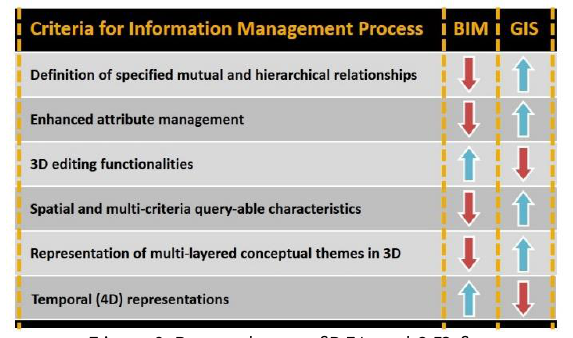
Figure 6. Pros and cons of BIM and GIS for information management of historic